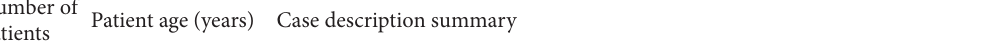
Table 1: Summary of case series documenting use of carbamazepine therapy in the treatment of SSPE. Number of